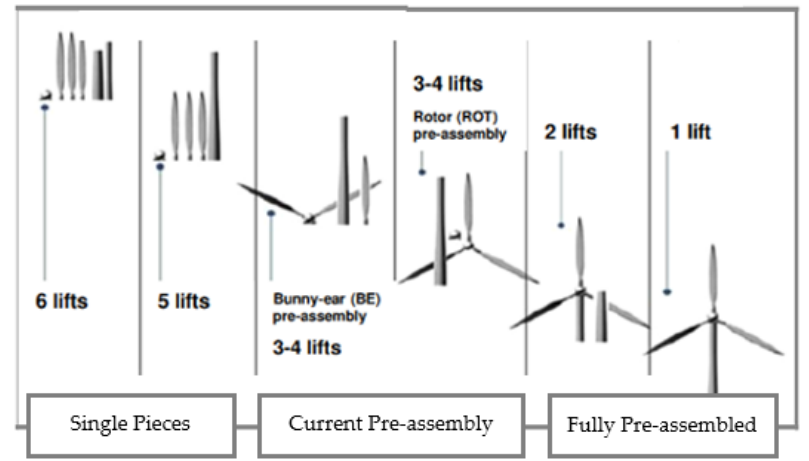
Figure 3. Offshore wind turbine current and proposed installation methods. Adapted from [20].